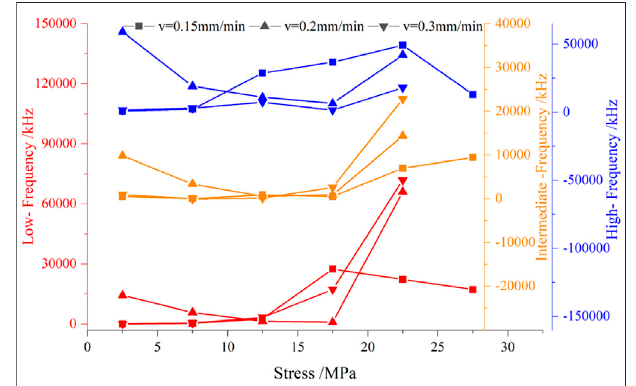
FIGURE 6 | Variation of frequency value with peak stress in each frequency band under different loading